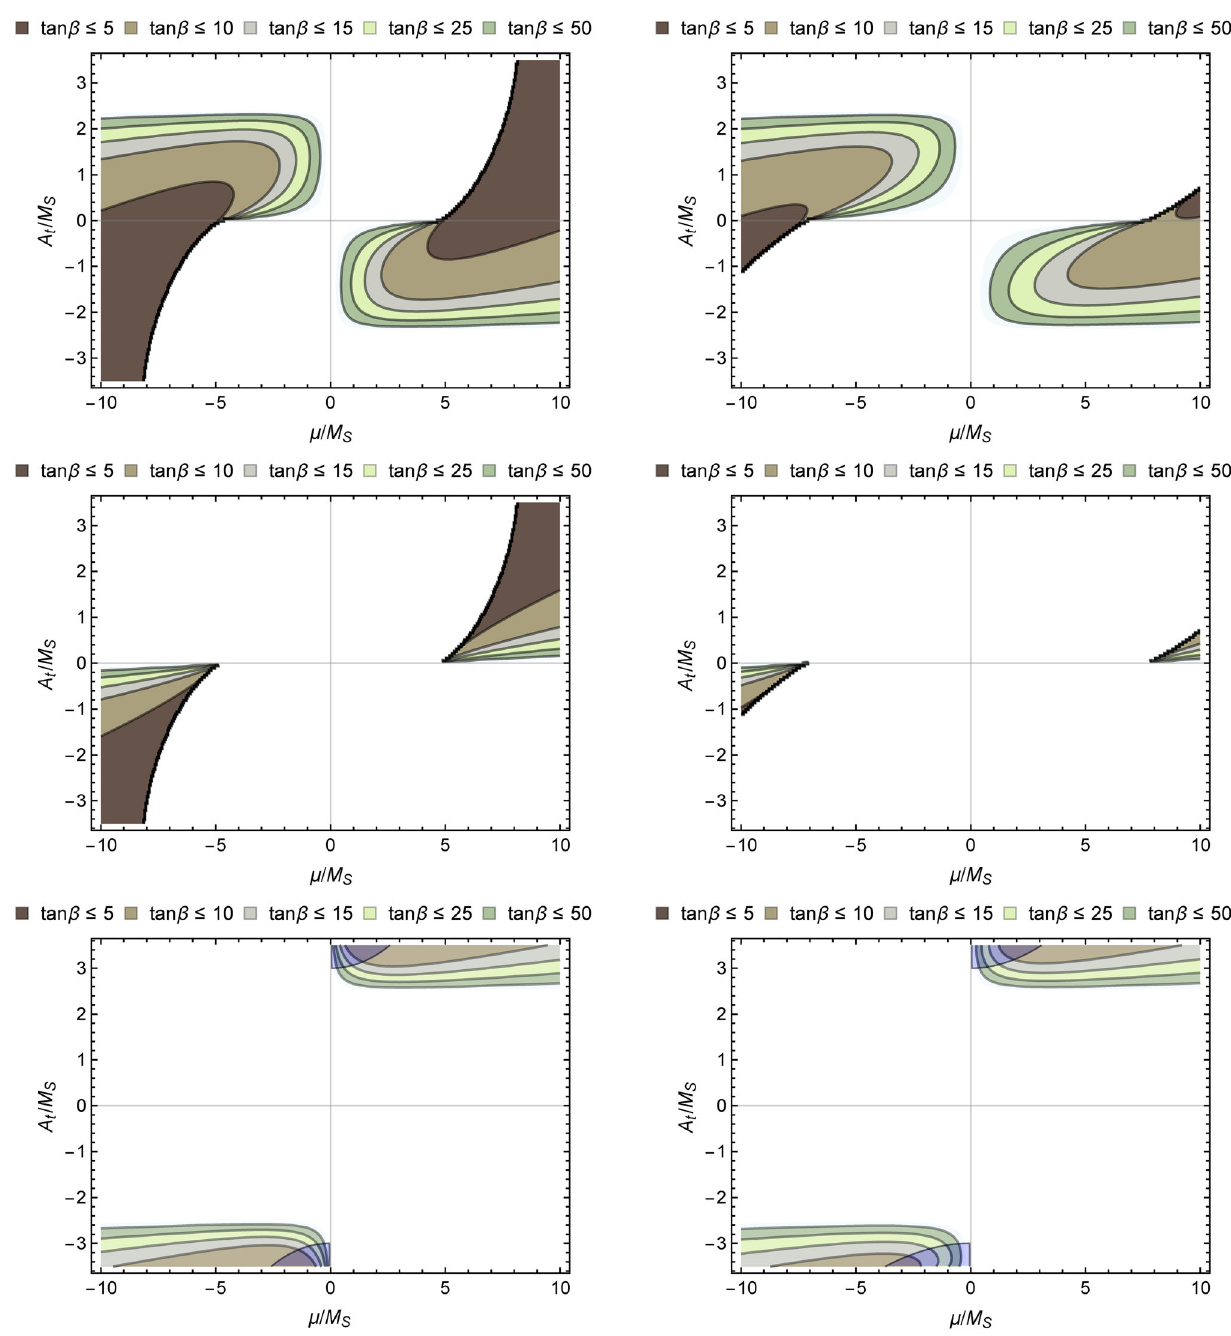
Fig. 3 Contours of tan β corresponding to exact alignment, Z 6 = 0, in the (μ/ M S , A t / M S ) plane. Z 1 is adjusted to give the correct Higgs mass. Left: Approximate one-loop result; right: two-loop improved result. Taking the three panels on each side together, one can imme-